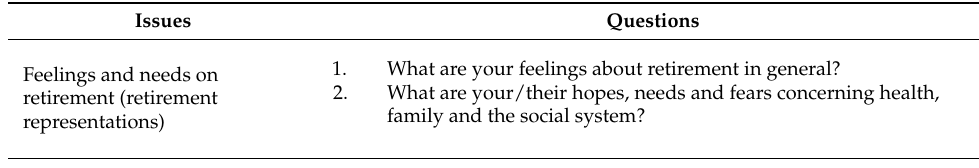
Table A1. Topic-guide of the Wave 1